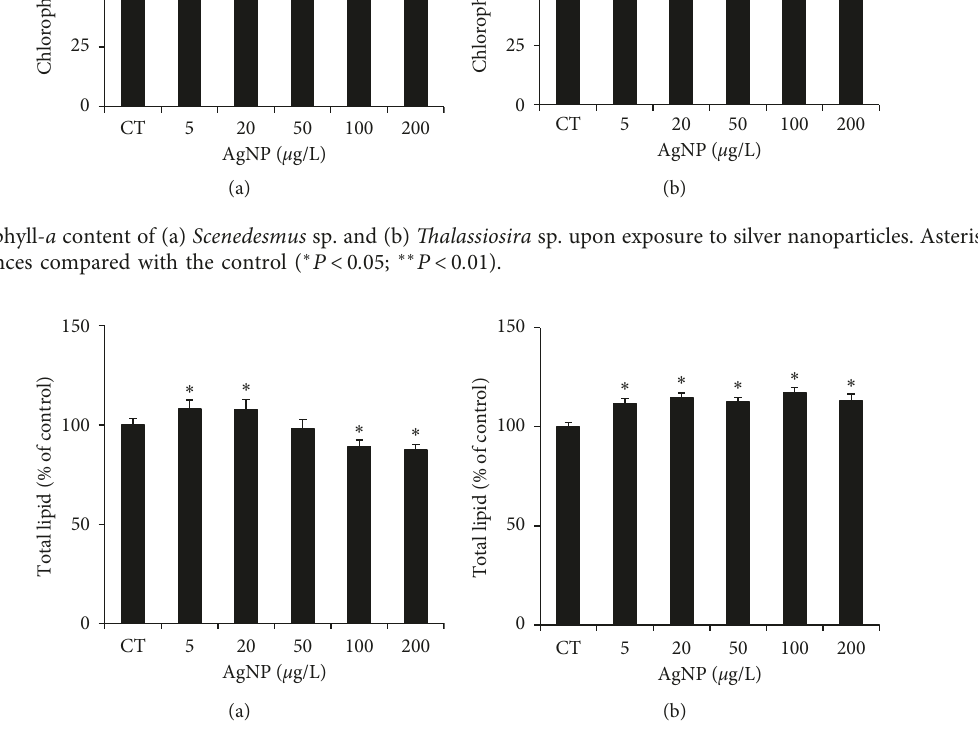
Figure 5: Total lipid content of (a) Scenedesmus sp. and (b) Thalassiosira sp. upon exposure to silver nanoparticles. Asterisks indicate significant differences compared with the control ( ∗ P < 0 .